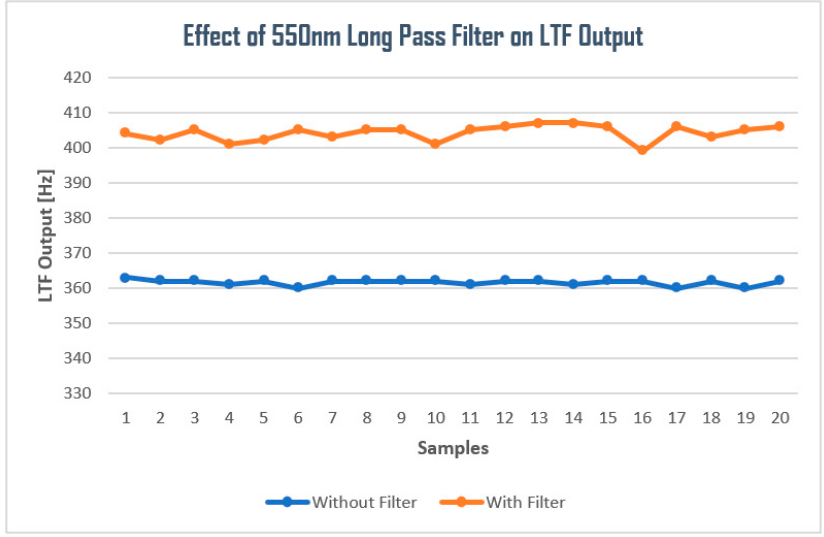
Figure 10. The effect of the 550 nm long pass filter on the GDD detector at full MMW source output power.